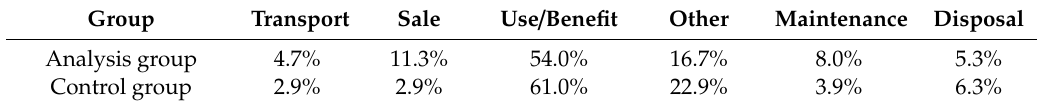
The percentages have been obtained by referring to the total counts obtained by each